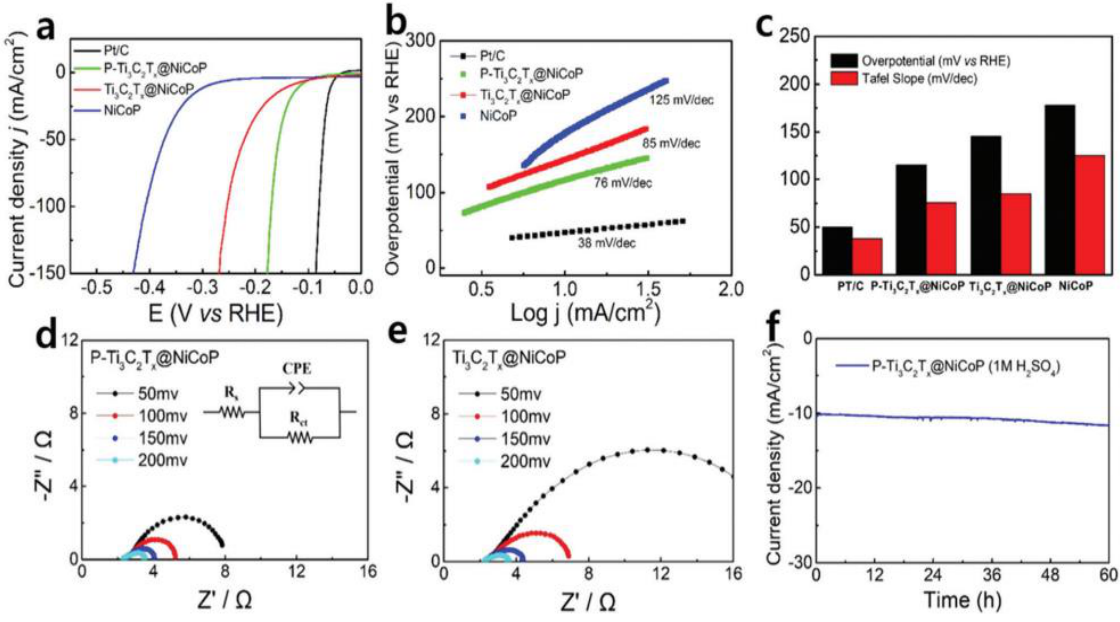
Figure 7. Electrocatalytic HER performances of various samples in acid. ( a ) HER polarization curves (95% iR-compensated) measured at 5.0 mV/s in 0.5 M H 2 SO 4 , ( b ) corresponding Tafel plots, ( c ) over- potential, Tafel summary plot at 5.0 mV/ s in 0.5 M H 2 SO 4 , Nyquist plots of ( d ) P-Ti 3 C 2 Tx@NiCoP, ( e ) Ti 3 C 2 Tx@NiCoP measured at different scan rates in 0.5 M H 2 SO 4 and ( f ) current density-time (I-t) curves at an overpotential of 125 mV. Adapted with permission from [183], Copyright 2021, Royal Society of Chemistry.